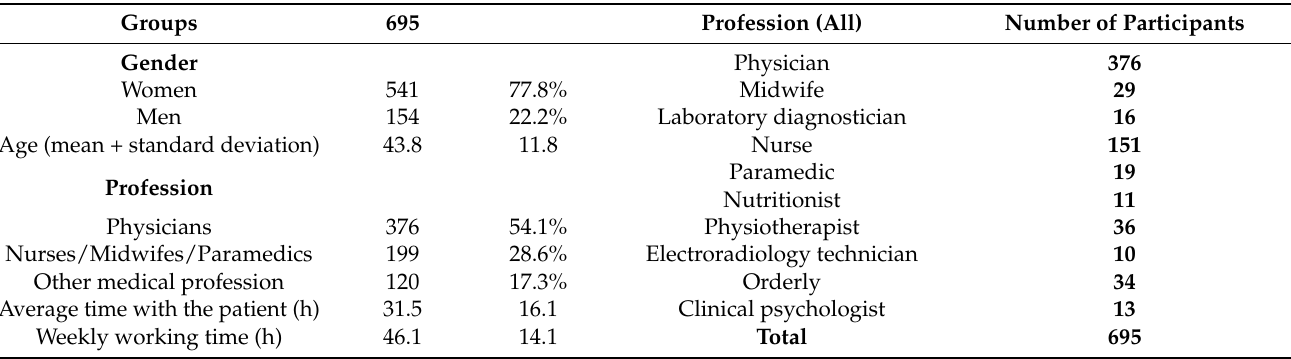
Figure 1. Flow diagram. Table 3. Baseline characteristics with profession